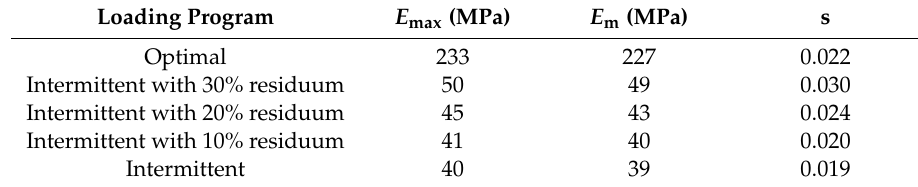
Table 2. Parameters for the analyzed loading programs for the time interval t = 10 (time unit).